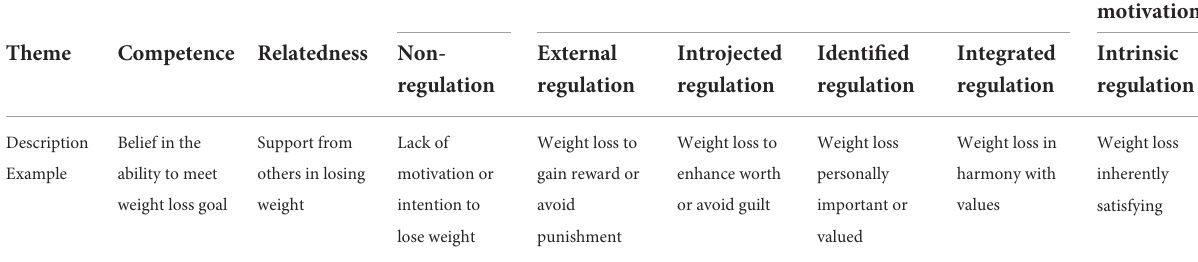
TABLE 2 Identified themes per self-determination